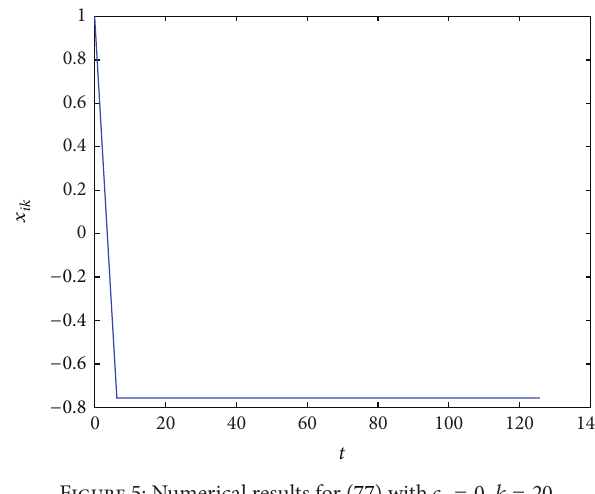
Figure 5: Numerical results for (77) with 𝑐 1 = 0 . 𝑘 = 20 .